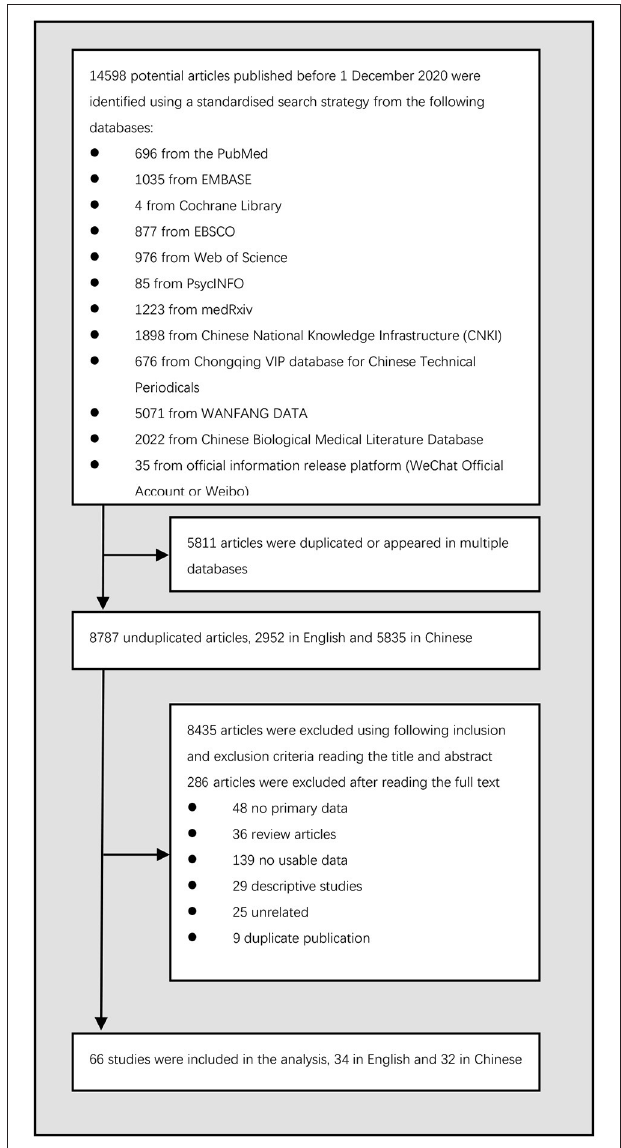
FIGURE 1 | Identification of included